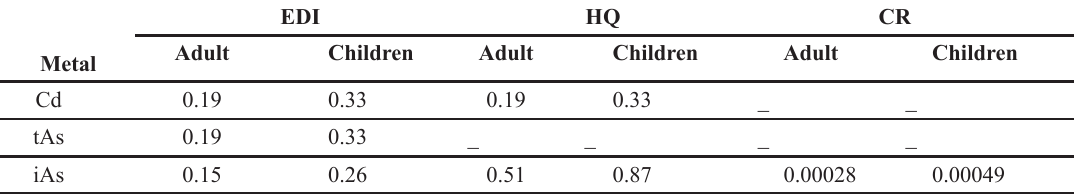
Table 3: Estimated Daily Intake, Target Hazard Quotient and Cancer Risk of As and Cd through rice consumption by Sri